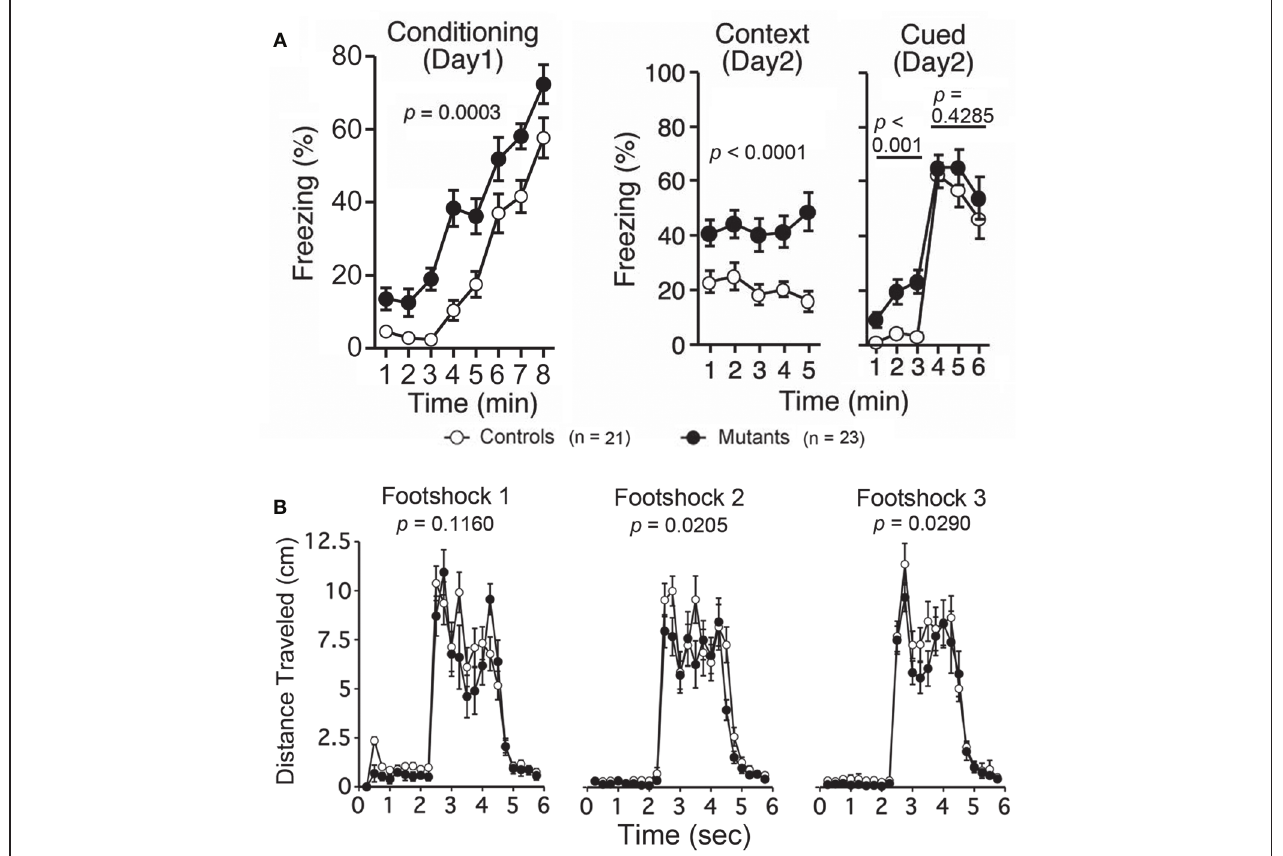
testing with altered context before the auditory cue (before tone), while freezing after the auditory cue (after tone) was normal. (B) Apc + / − mice showed a decrease in distance traveled immediately after footshocks 2 and 3 in the training phase. Apc + / − mice, n = 23; wild-type mice, n =